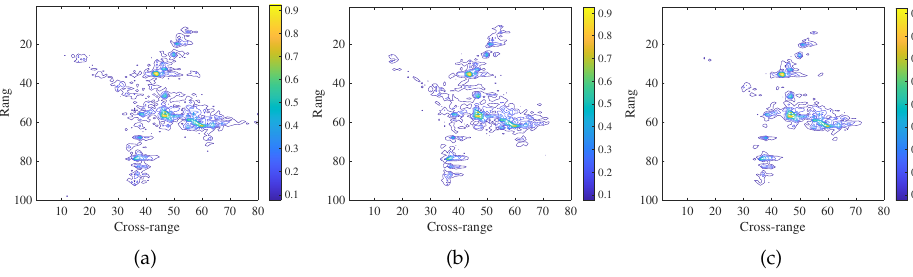
Figure 12. The target images of 50% measurements of plane data obtained by GDL method in the three cases of ( a ) λ = 0.02, ( b ) λ = 0.03, and ( c ) λ =